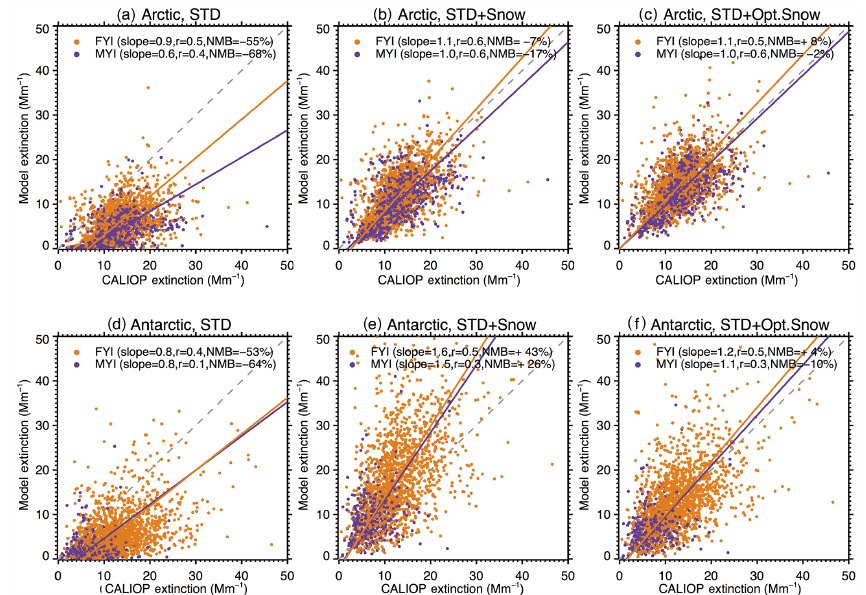
Figure 2. Scatter plot of CALIOP and GEOS-Chem aerosol extinction coefficients over FYI (orange circles) and MYI (purple circles) for the Arctic cold season (November–April, a–c ) and Antarctic cold season (May–October, d–f ). Each symbol represents the monthly aerosol extinction coefficients for individual grid boxes (2 ◦ × 5 ◦ , 0–2km) over sea ice. The dashed gray line is the 1:1 line. The purple and orange lines are the linear fit for the points over MYI and FYI, respectively. The slope of the regression line, correlation coefficient ( r ), and normalized mean bias, NMB = 100 × ( Model / Obs − 1 ) , are shown for each